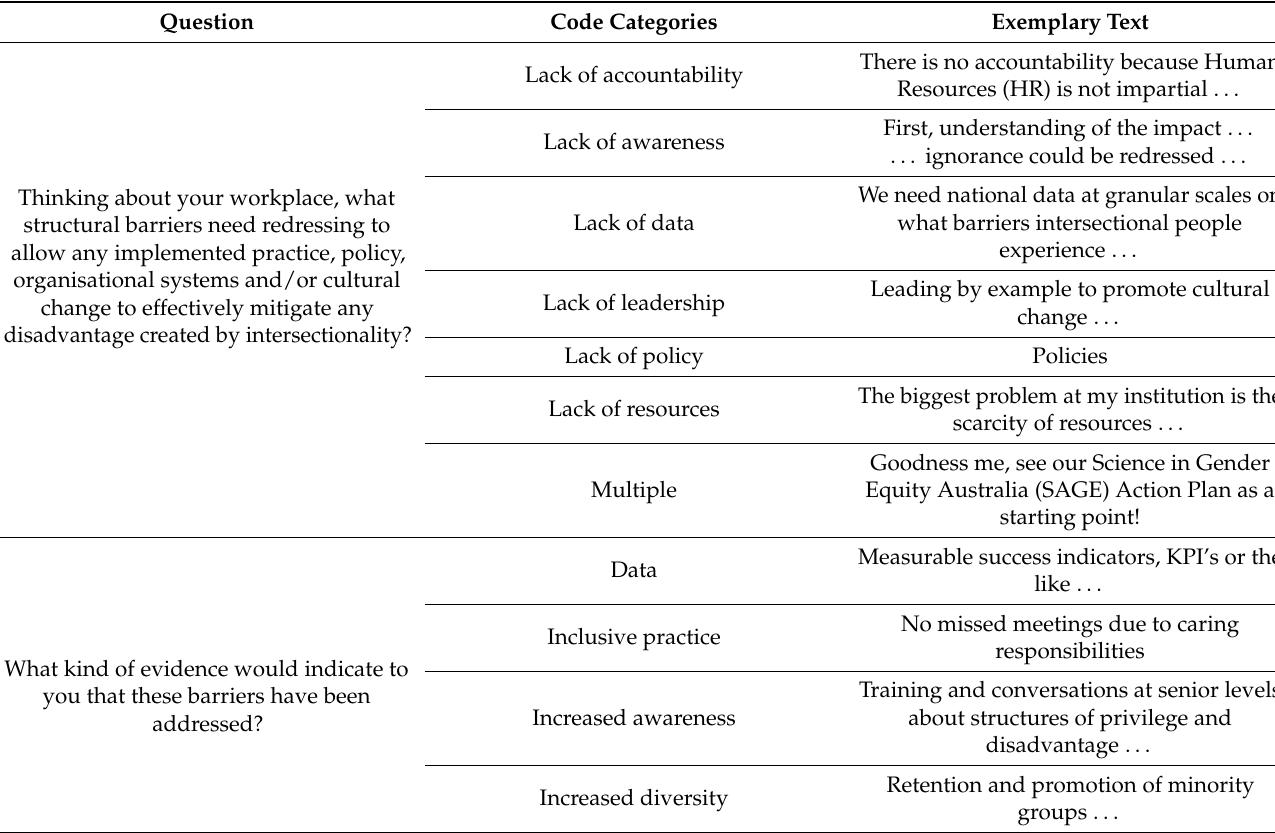
Table 1. Categories and exemplary phrases and words used in qualitative data